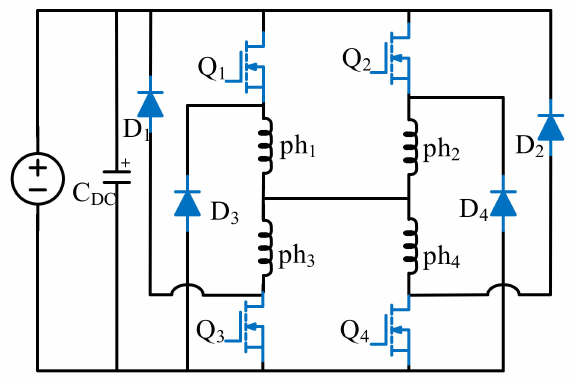
Figure 15. H-bridge soft-switched